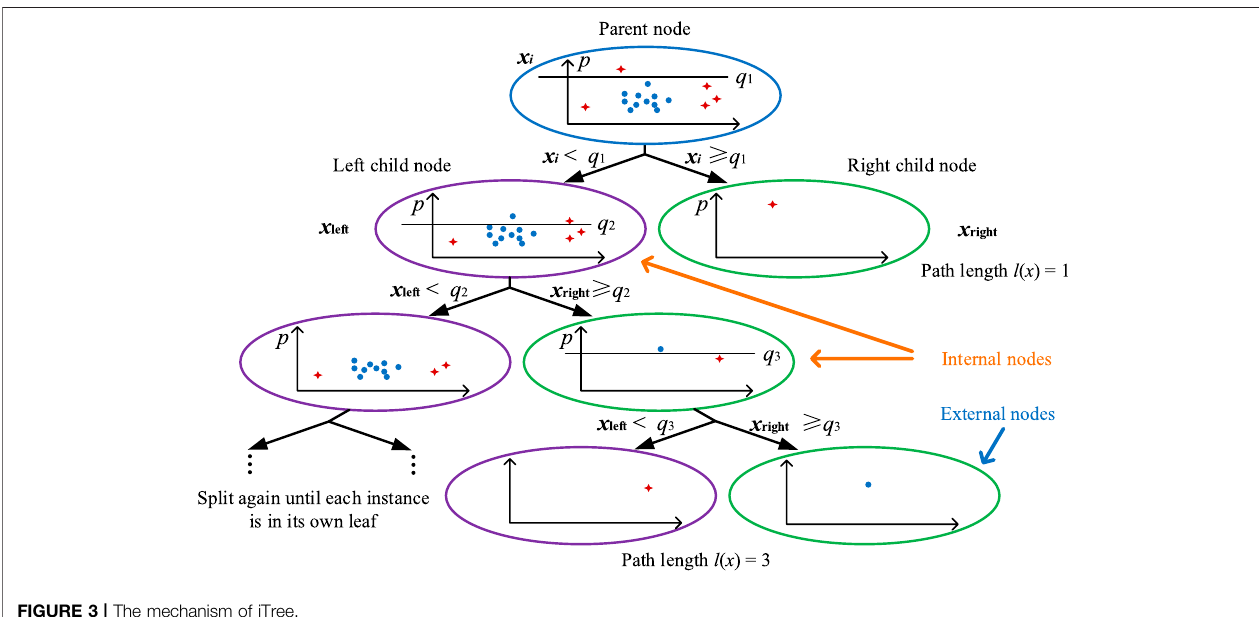
FIGURE 3 | The mechanism of